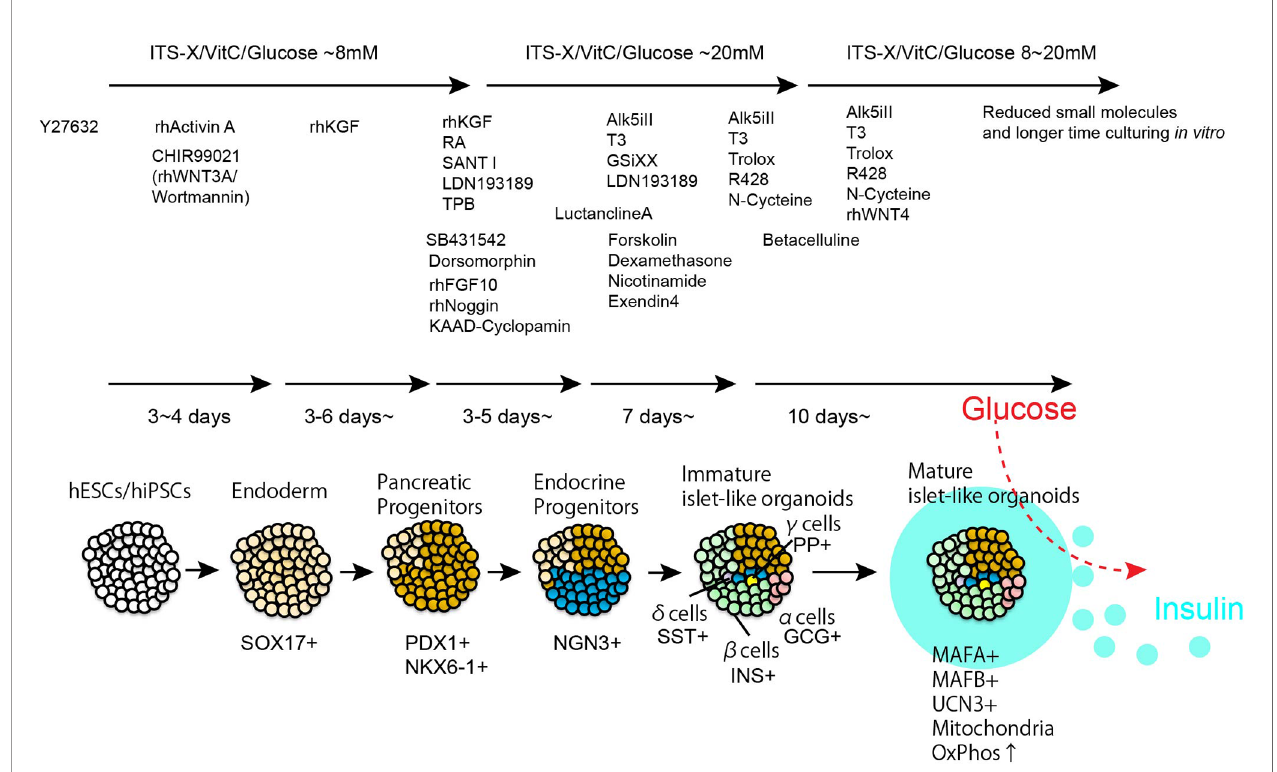
FIGURE 1 | Step by step differentiation and maturation to generate functional human islet-like organoids. By using chemically de fi ned recombinant proteins and small molecules, hPSCs are introduced pancreatic lineage speci fi cation. Islet-like organoids contains insulin producing b -cells, glucagon producing a -cells, somatostatin producing d -cells, and pancreatic polypeptide producing g -cells. The representative duration and small compounds/recombinant proteins used for b - cells differentiation are listed in the